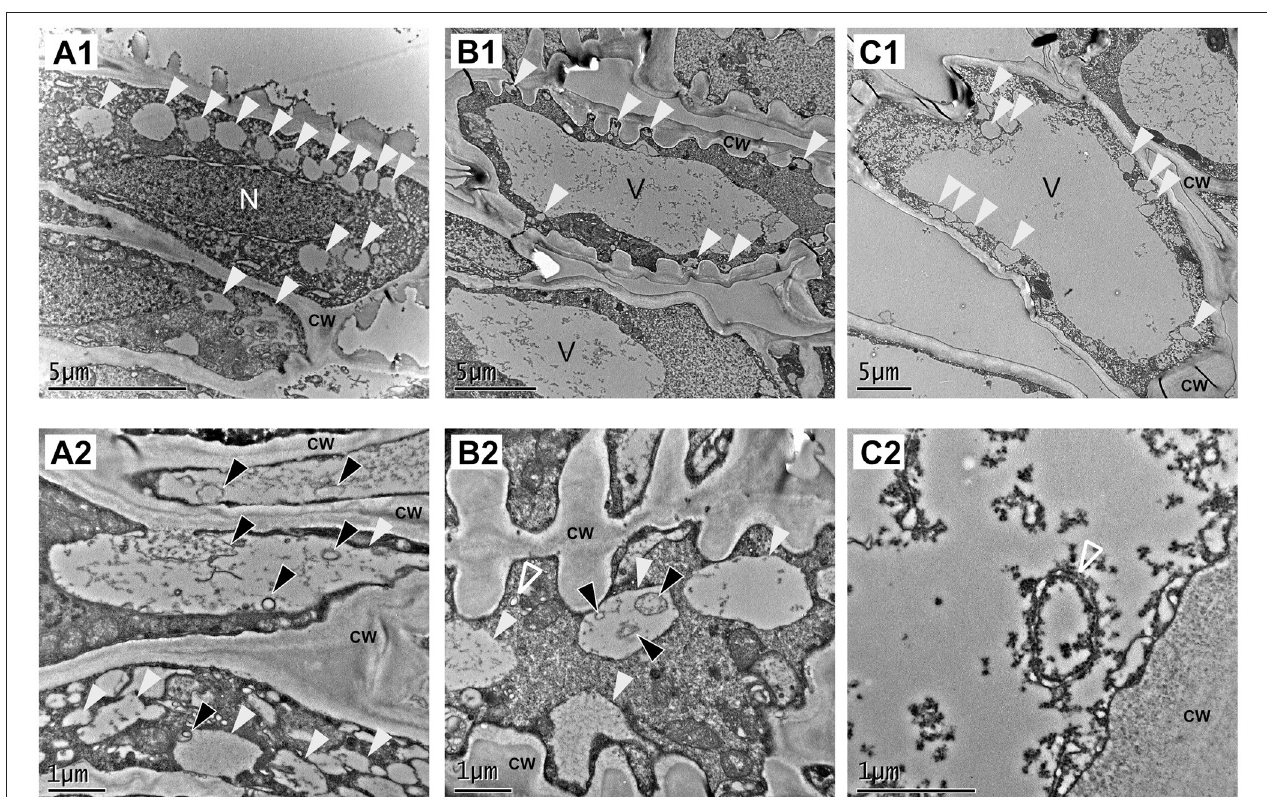
FIGURE 3 | Vascular tissue is a place of active autophagy. TEM micrographs from representative cells of the green receptacle vascular tissue. (A – C) Different cell types found in vascular tissue. (A,C) Parenchymatic cells of the vascular tissue. (B) Immature xylem cells. (1) Overview of the cells and (2) close up of the same type of cells showing autophagy-related structures. White arrowheads: single membrane compartments with degraded content, black arrowheads: autophagic bodies, empty white arrowheads: autophagosomes. CW, cell wall; n, nucleus; v, Vacuole.